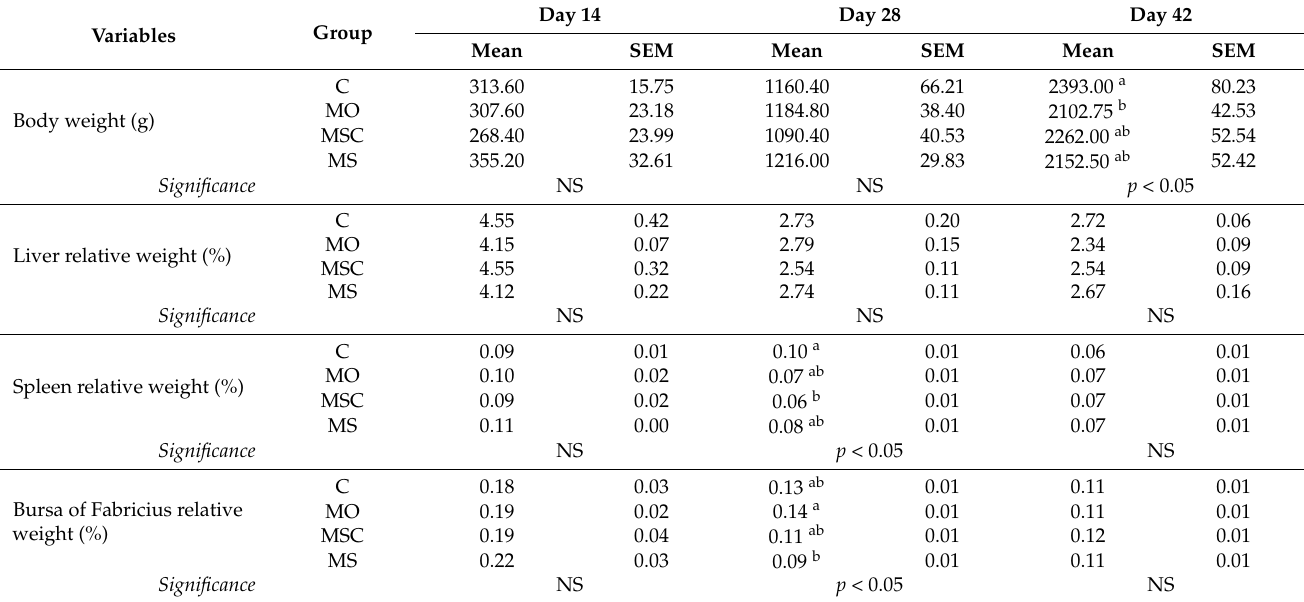
Table 2. Effect of dietary treatments on the body weight and the relative weight 1 of liver, spleen, bursa of Fabricius of